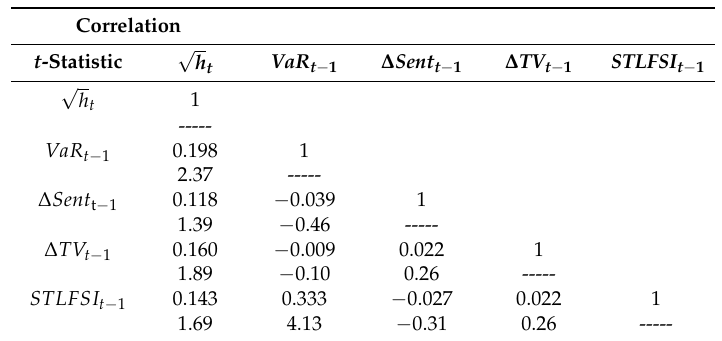
Table 2. Correlation analysis of the independent variables in the stock return equation for Chinese